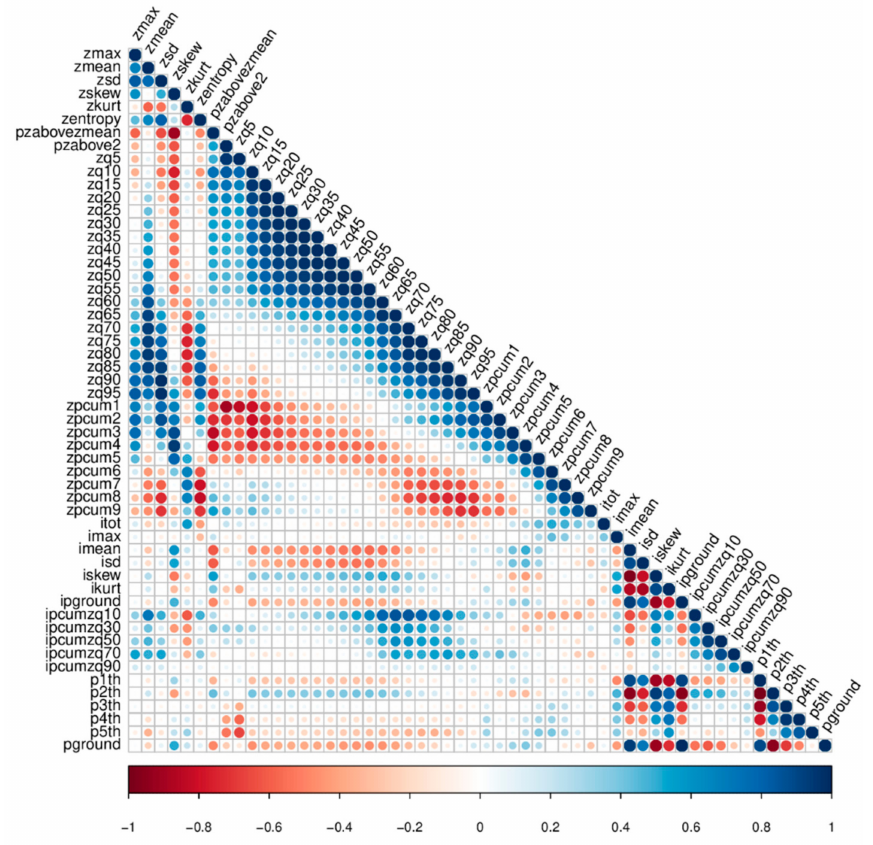
Figure 3. Correlogram between the 54 extracted LiDAR